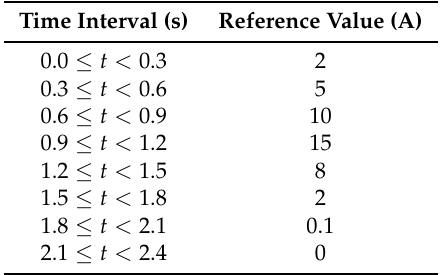
Table 4. Values of the current reference i ∗